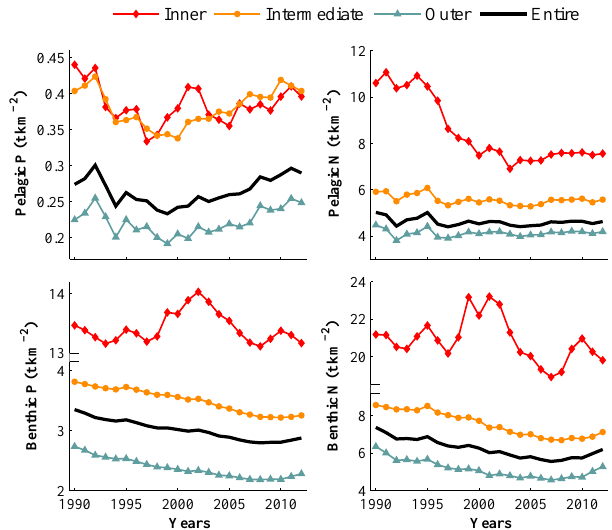
Figure 12. The total content (gm − 2 ) of the pelagic (top) and ben- thic (bottom) P (left) and N (right) in the inner (diamonds), interme- diate (circles), outer (triangles) and entire (black line) Stockholm